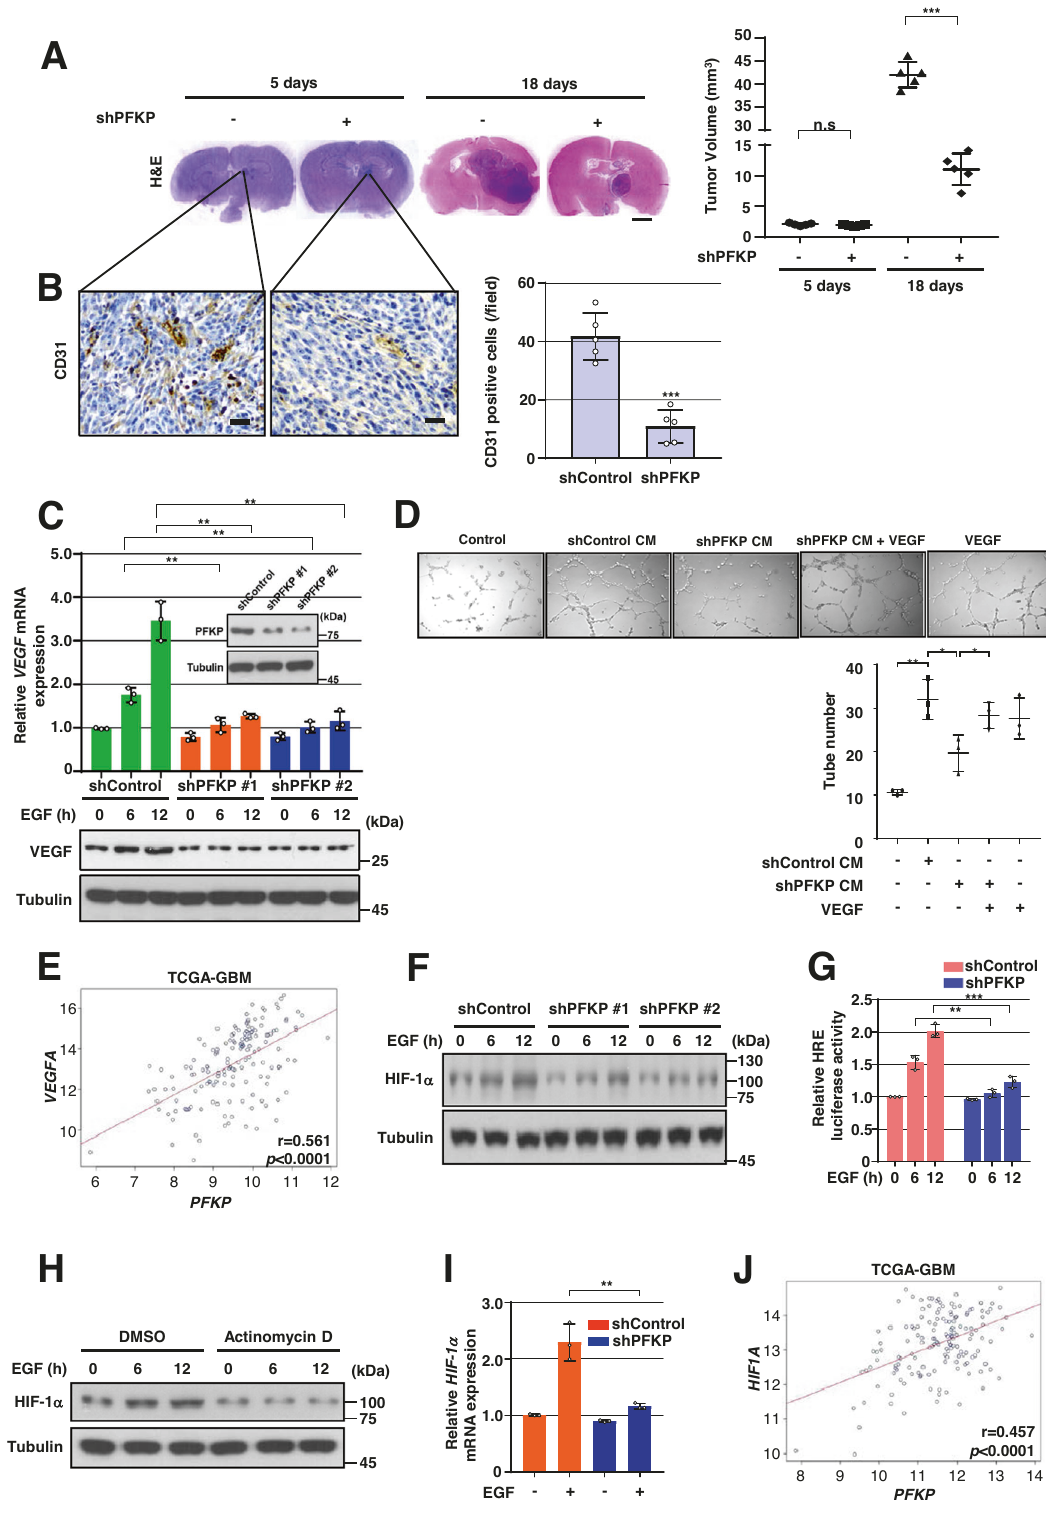
naïve LN229 cells (Supplementary Fig. S1C). Depletion of PFKP expression also decreased blood vessel formation. However, tumor sizes were comparable between groups injected with control shRNA-expressing and PFKP shRNA-expressing LN229 cells at an early stage (Supplementary Fig. S1C). These results